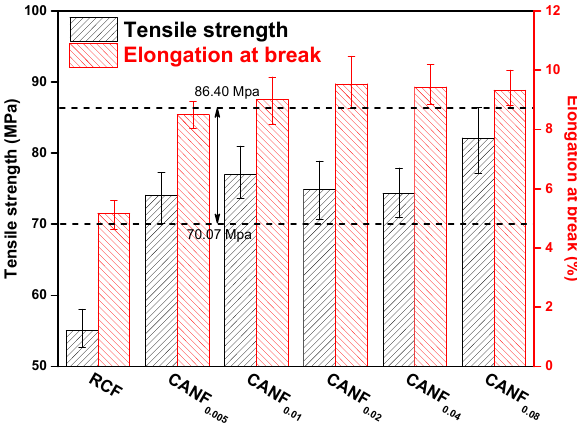
Figure 8. Tensile properties histogram of composite films.